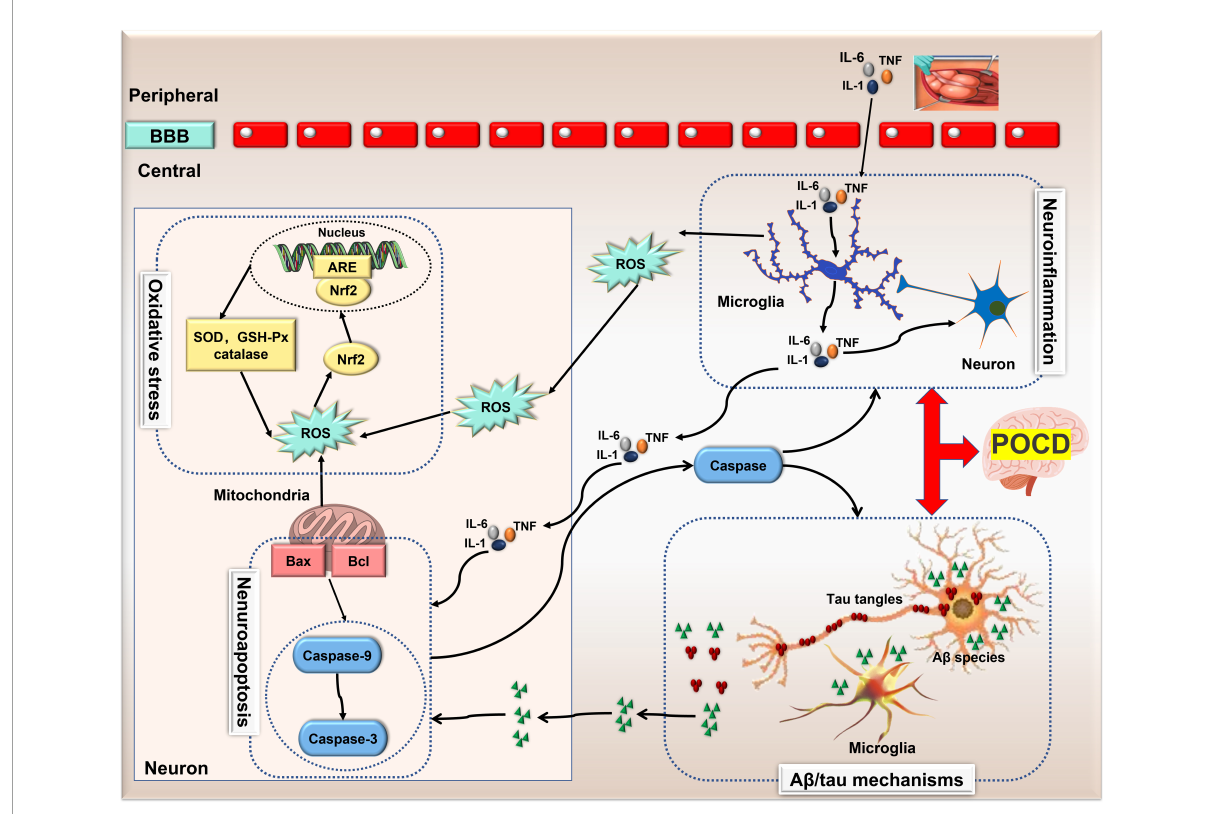
FIGURE1 The pathological mechanisms of POCD. Neuroinflammation, A β deposition/tau hyperphosphorylation, neuronal apoptosis and oxidative stress are four recognized pathological mechanisms involved in POCD. Neuroinflammation can induce neuronal apoptosis and oxidative stress via microglia-secreted cytokines and reactive oxygen species, and in turn, apoptosis-related protein caspase-1 exacerbates neuro-inflammation. However, this bidirectional communication also exists between neuronal apoptosis and changes in A β peptide. Thus, these mechanisms can interact with one another exacerbating the pathological outcomes of POCD. A β , amylase- β ; ARE, antioxidant response element; BBB, blood brain barrier; GSH, glutathione; IL, interleukin; lncRNA, long non-coding RNA; nuclear factor-erythroid 2-related factor 2 (Nrf2); ncRNA, non-coding RNA; POCD, postoperative cognitive dysfunction; ROS, reactive oxygen species; SOD, superoxide dismutase; TNF, tumor necrosis